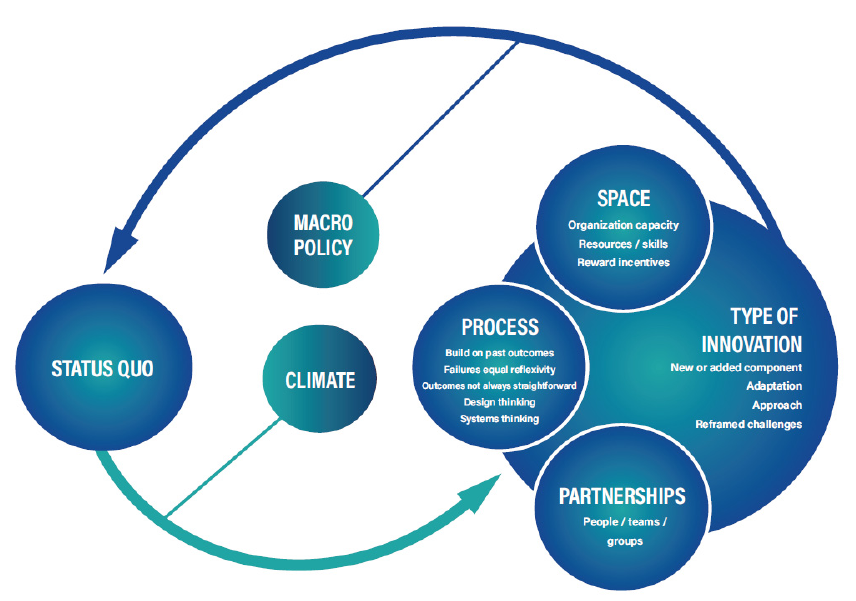
Figure 1. The Framework for Public Health Innovation.